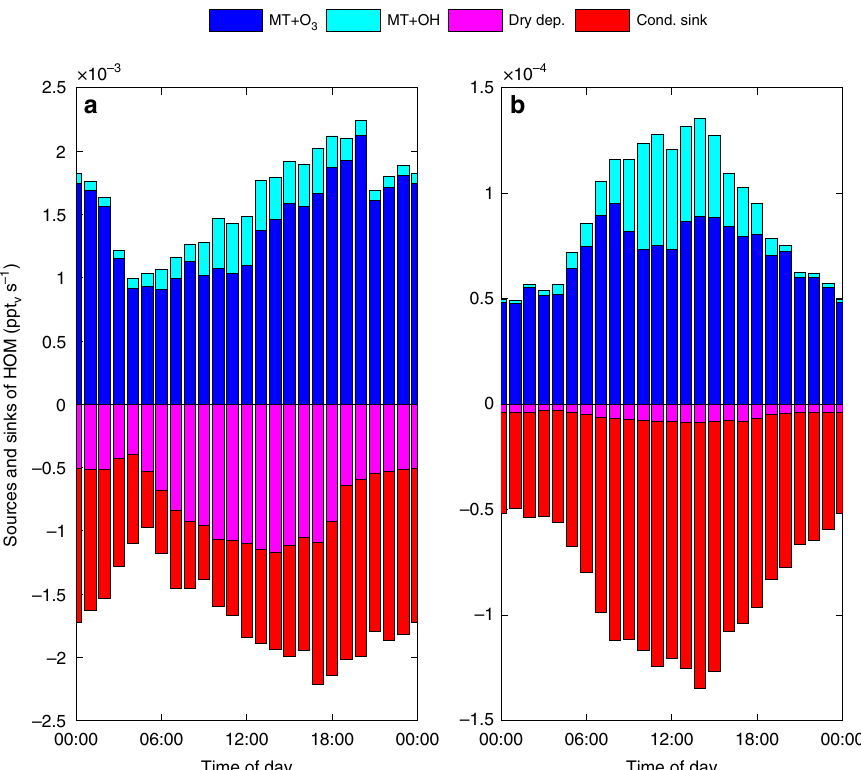
Fig. 4 Sources and sinks of highly oxygenated organic molecules (HOM). Modelled median diurnal trends of the sources and sinks of HOM at the Station for Measuring Ecosystem-Atmosphere Relations II (SMEAR II) between 15 and 24 May 2013. Panel a shows the sources and sinks inside the forest canopy (0 – 18 m above ground) while panel b shows the integrated sources and sinks between 0 and 2500 m above the ground. Note the different scales on the y - axes. The panels show the sources of HOM(g) from monoterpenes (MT) oxidized with O 3 and OH and the sinks due to dry deposition and condensation